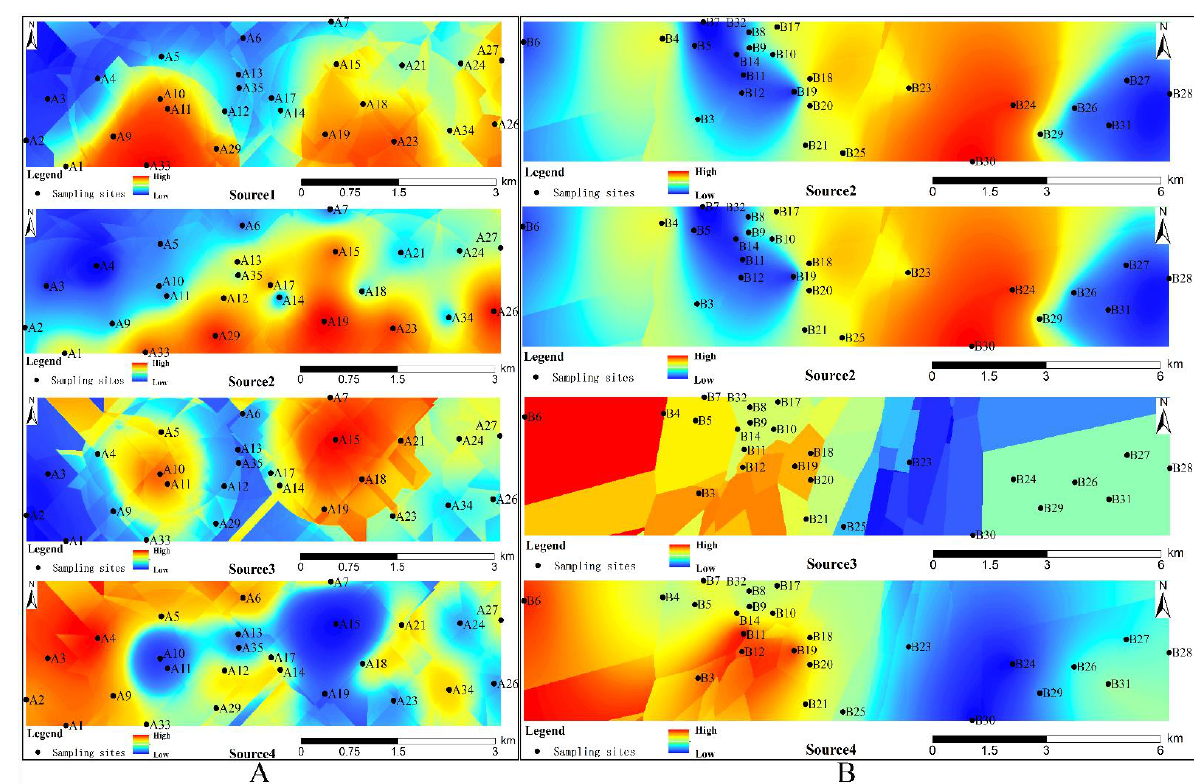
Figure 5. Source contribution spatial distribution. ( A ) Qinzhou district; ( B ) Maiji district.